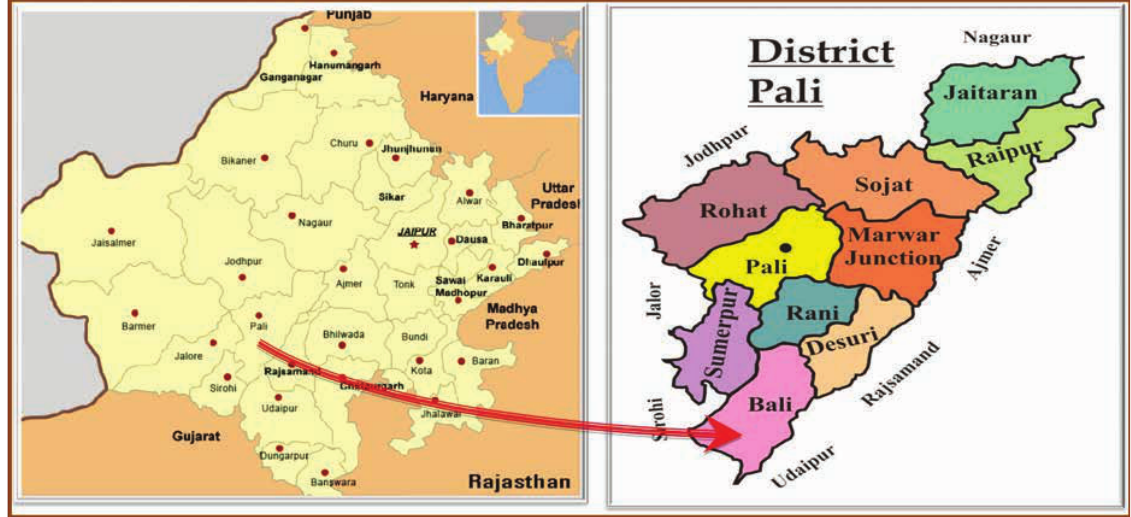
Figure 1: Location of case